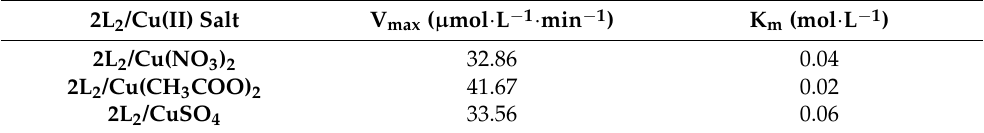
Table 4. Values of the V max and K m